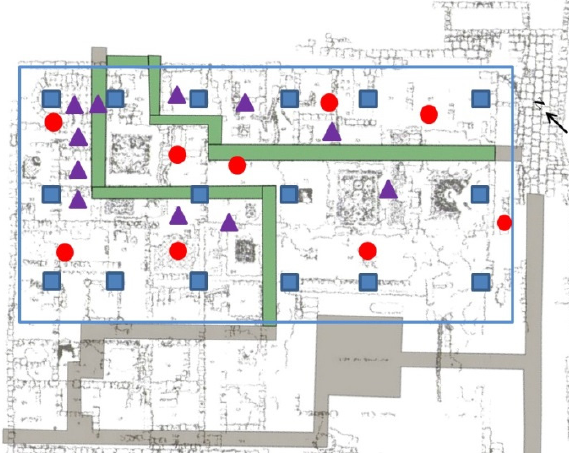
Figure 4. Roman Domus plan with Tocon GLS-2000 scan positions: in red the traverse scans and in violet the “single scans” (roof pillars in blue and wooden walkways in green and